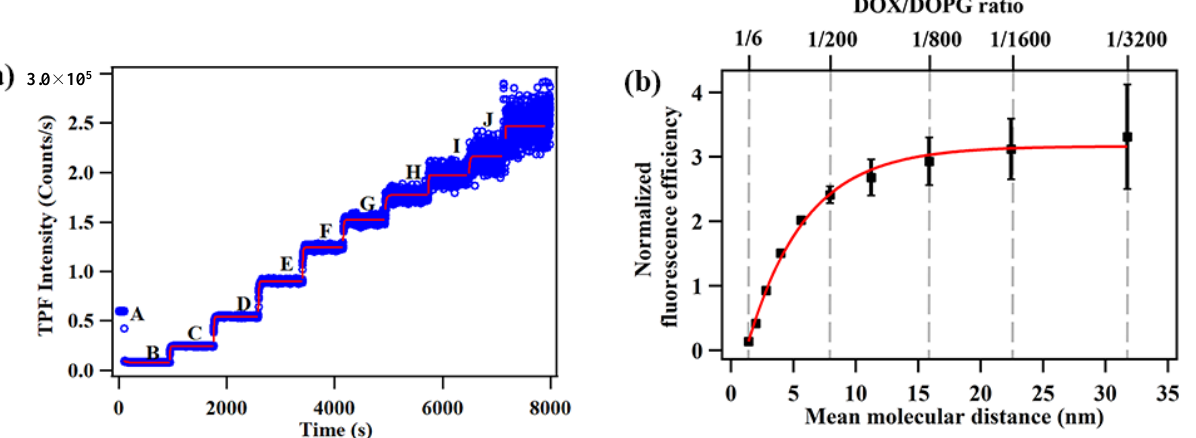
Figure 7. ( a ) Time-dependent TPF intensity curves obtained from the DOX solution upon 810 nm laser radiation with multiple times addition of DOPG vesicle solutions at the points indicated by A–J. After halving the DOX concentration at each point, the TPF signal was doubled to make a fair comparison of the TPF efficiency. ( b ) TPF efficiency of DOX on the lipid surface with the apparent mean distance between the DOX molecules. Values were normalized to the TPF efficiency of DOX in their 40 µ M aqueous solution. The data were averaged results based on two batches of measurements. Reproduced with permission [61]. Copyright 2019 American Institute of